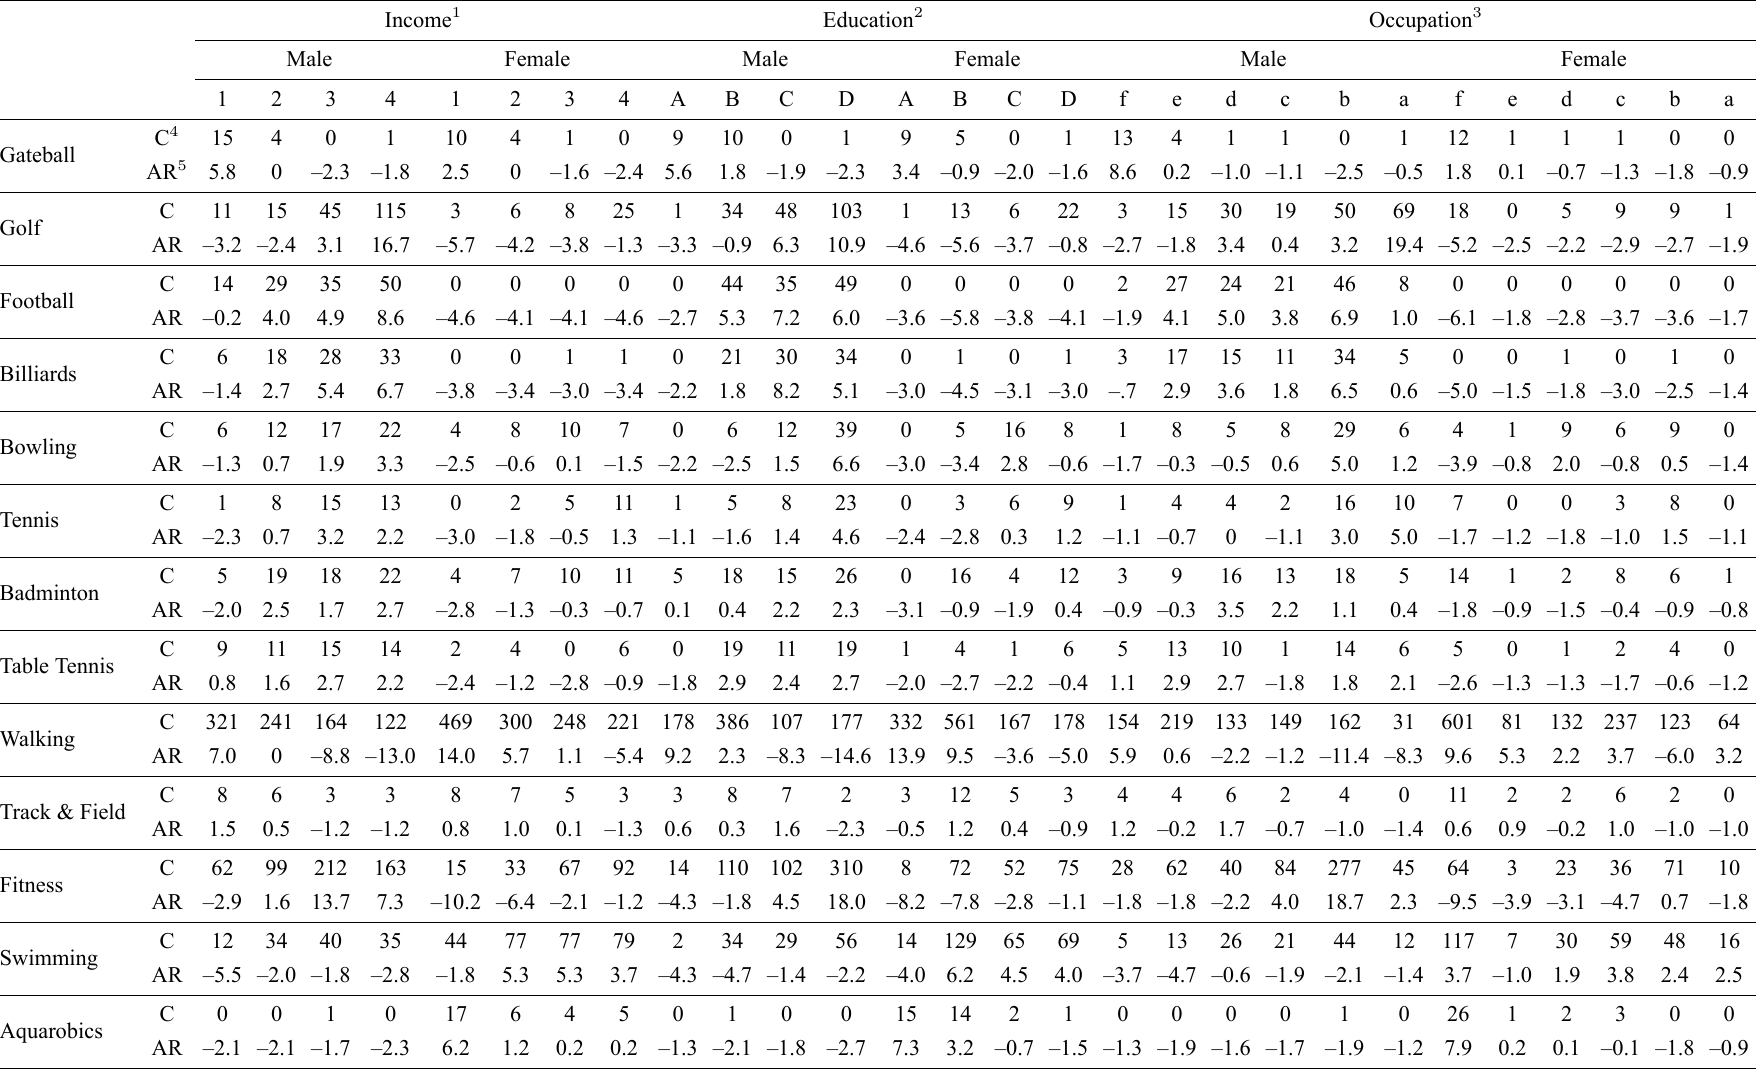
Table 2. Cross-tab results of types of sports participation according to gender and social